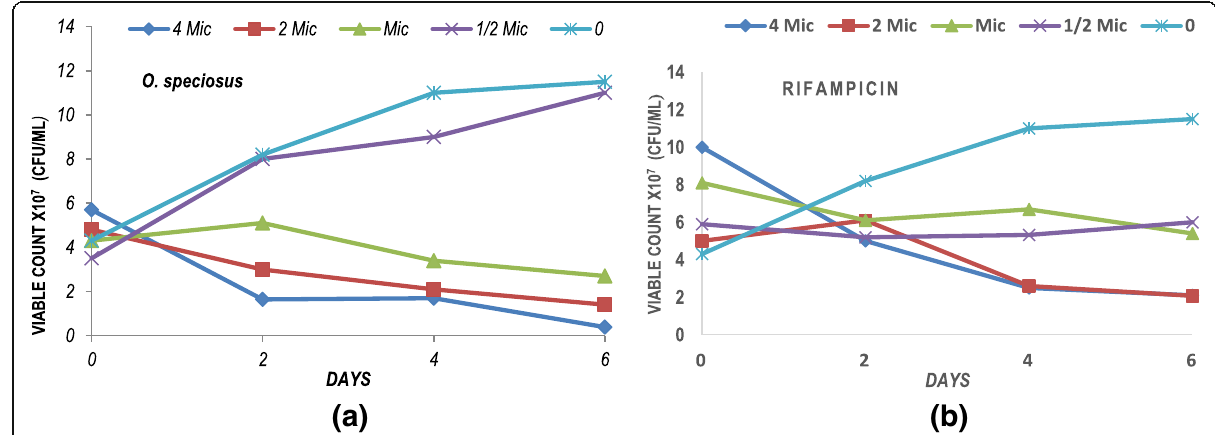
Fig. 3 RAW 264.7 cells infected with Mycobacterium fortuitum with a MOI 1:5 (cells:bacilli) were exposed to several concentrations of extract and rifampicin (0.5X, 1X, 2X and 4X MICs, 0 = untreated control) in triplicate. After 2, 4 and 6 days post infection, cells were lysed and plated on 7H10 agar to determine CFU/mL. Plots detail the bactericidal activity of extract of O. speciosus ( a ) and rifampicin ( b ) used as the reference positive control antibiotic. Values represent means ±